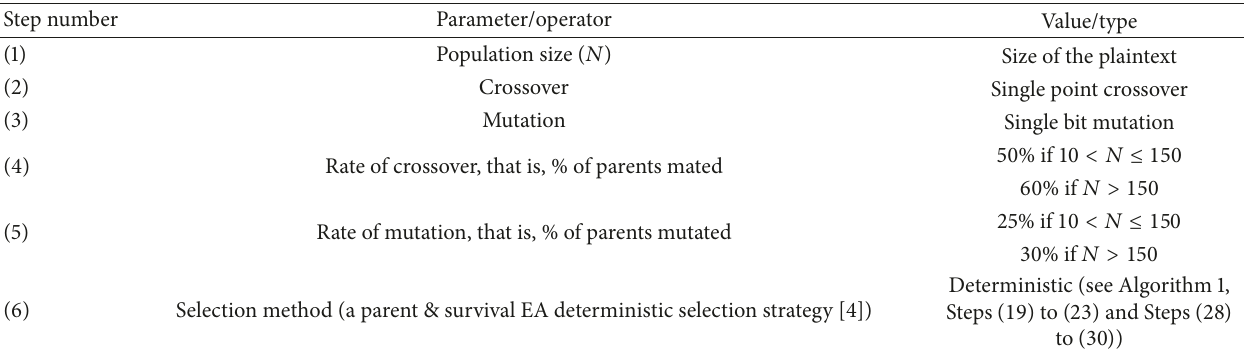
Table 2: Genetic parameters for the IGRKG